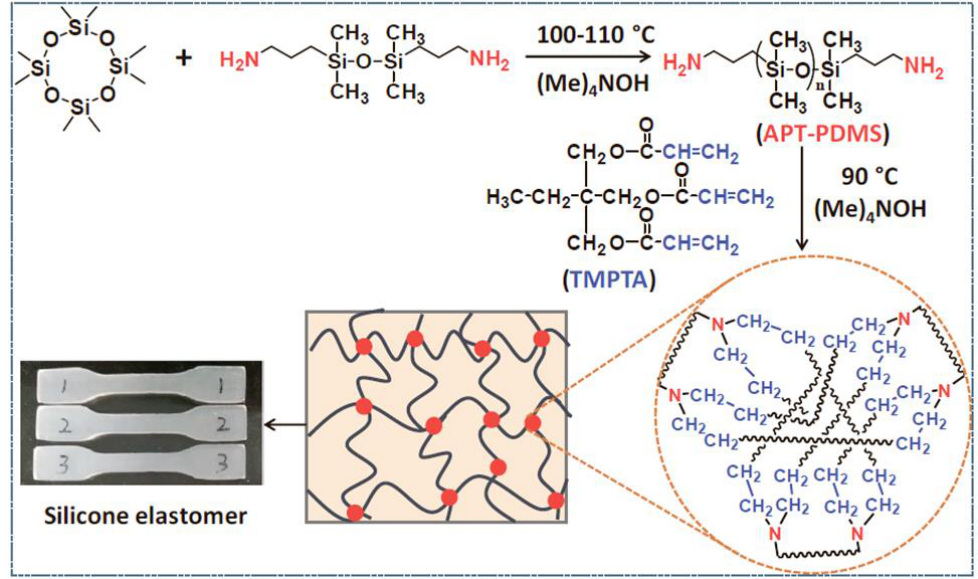
Figure 15. Illustration of the synthetic strategy and structure of silicone elastomer (adapted with permission from Ref. [104]. 2018, Li, X).